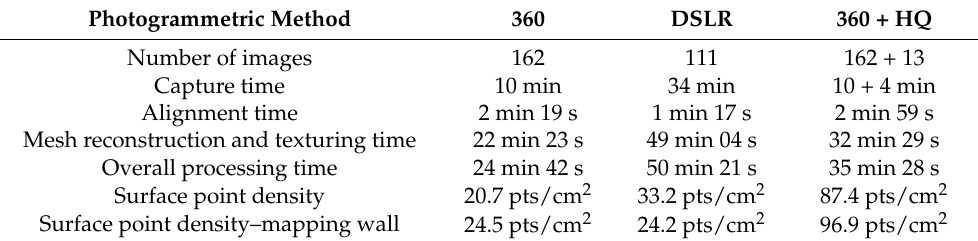
Figure 6. Top view ( left ) and front view ( right ) of the scanned tunnel 3D model reconstructed with SfM ‐ MVS photogrammetry from images captured using: ( a ) 360 ‐ degree camera, ( b ) DSLR camera, and ( c ) 360 ‐ degree camera and HQ images captured by a DSLR camera for improved resolution of the wall. Table 3. Image acquisition time and surface point density